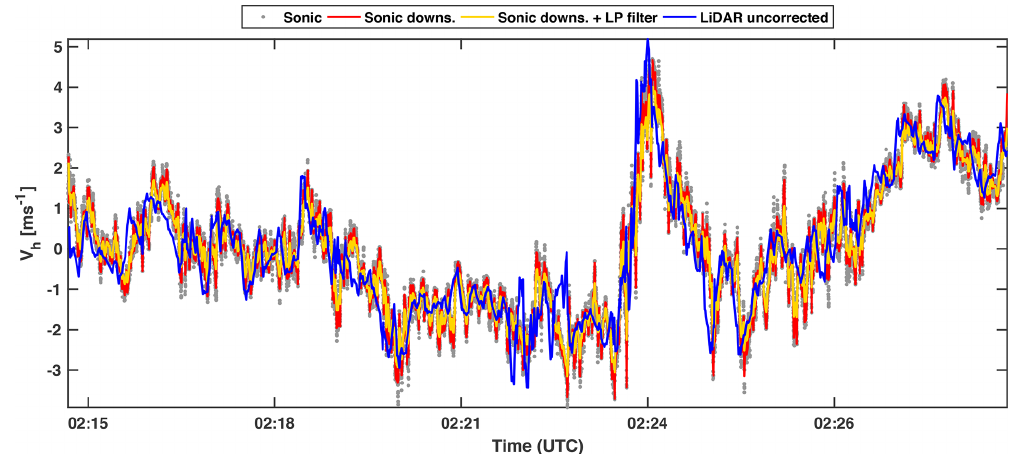
Figure 3. Subset of the horizontal velocity measured with a lidar and sonic anemometer from the XPIA dataset. The gray dots represent the original 20Hz sampled sonic-anemometer data, the red line is the sonic anemometer signal downsampled at 2Hz, the yellow line is the sonic anemometer signal after the convolution of Eq. (9), and the blue line is the lidar signal before the spectral correction.